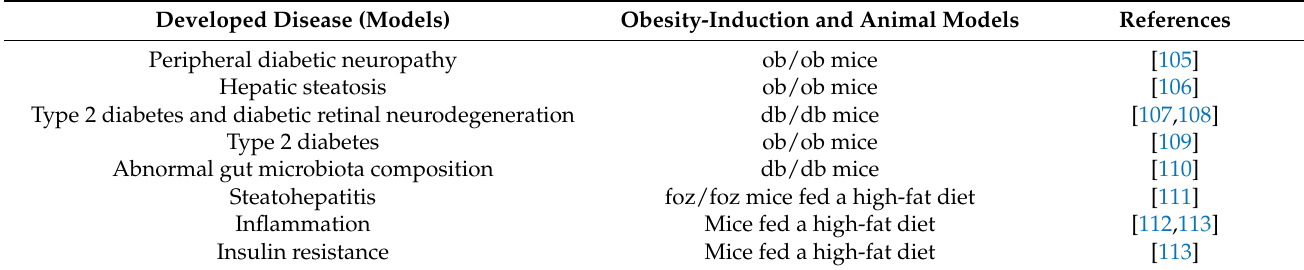
Table 1. Examples of obese mice that are used or could be used as disease/health condition models. Developed Disease (Models) Obesity-Induction and Animal